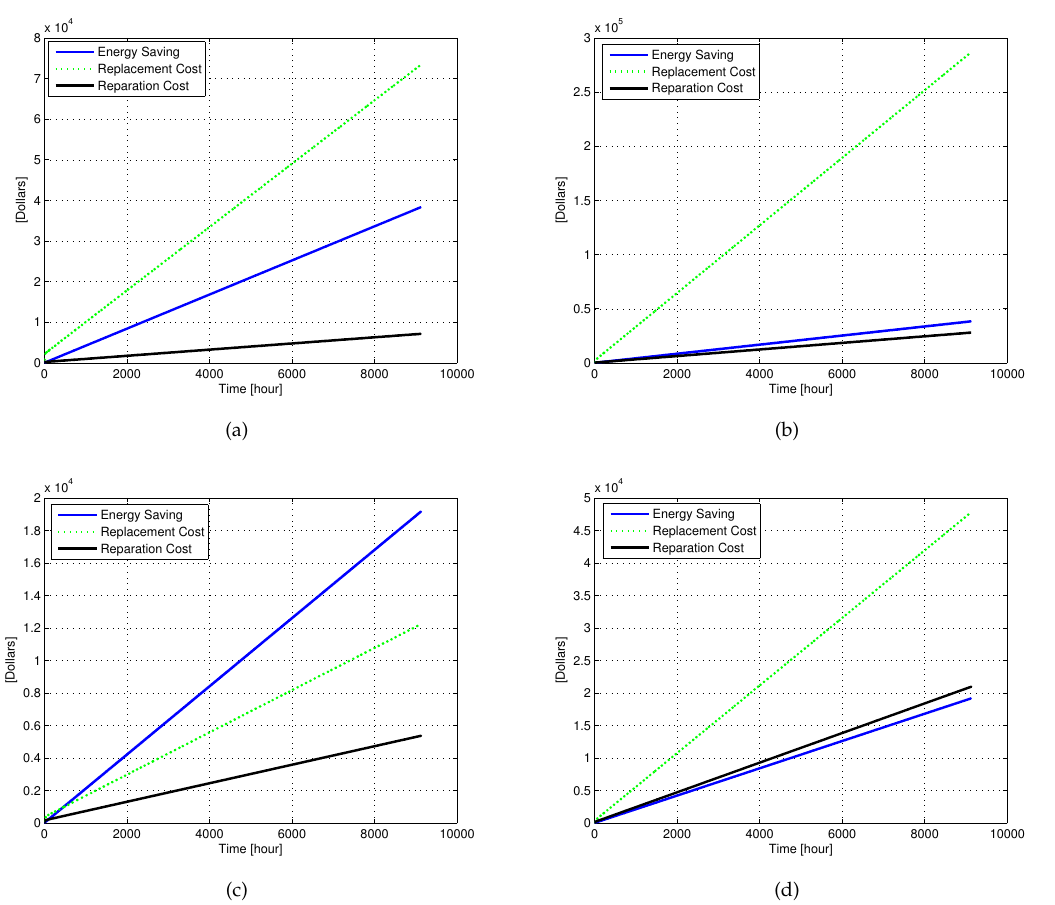
Figure 14. Cost Analysis for the LTE scenario. ( a ) LTE Micro BS- AF off = 0.2, χ off Micro BS- AF off = 0.5, χ off = 2 h/cycle; ( c ) LTE RRU Micro- AF off = 0.2, χ off ref Micro- AF off = 0.5, χ off = 2 ref